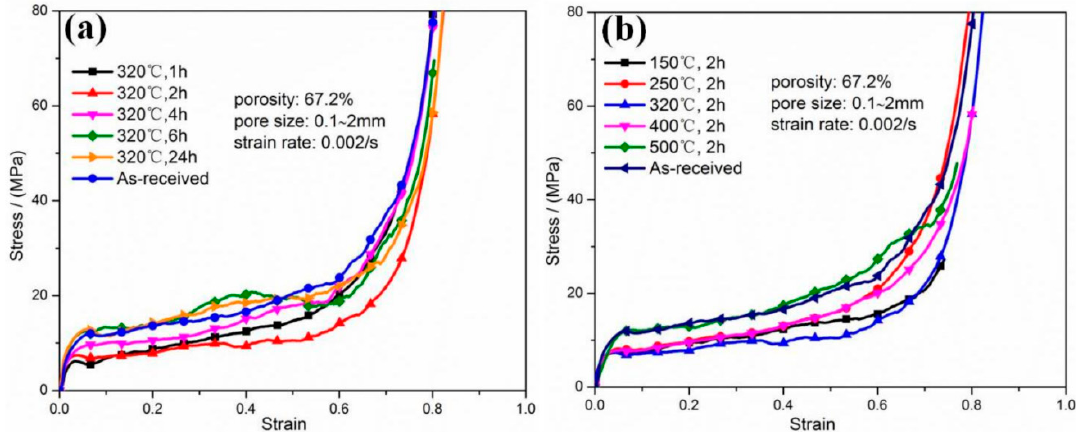
Figure 7. Compressive stress-strain curves of the composites foams: ( a ) heated at 320 °C with different holding times, and ( b ) foams with enduring time of 2 h at different heating temperatures.